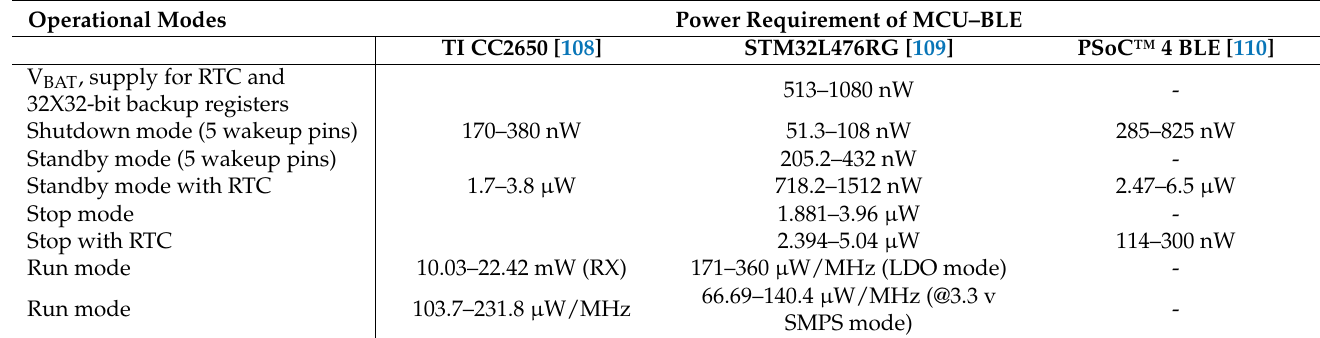
Table 4. The power consumption of the microcontroller unit with